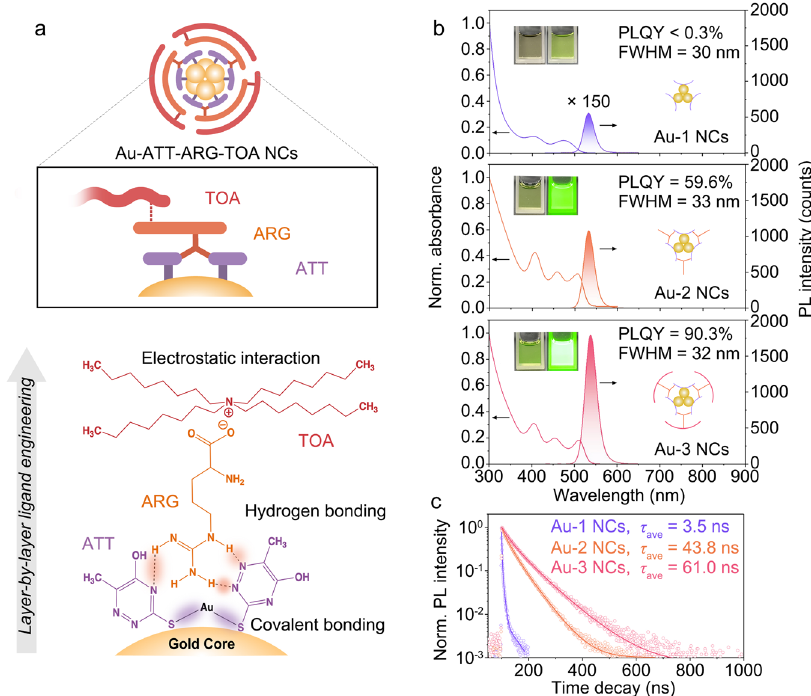
Fig. 1 | Structuralevolutionand opticalpropertiesofAu-1,Au-2, and Au-3NCs. a Schematic illustration of the triple-ligands layer-by-layer self-assembly evolution from the initial Au-1, intermediate Au-2, toterminalAu-3NCs. The schematicitems colored in purple,orange,and pinkdenotetogold NCscoated withATT, ARG,and TOA ligands, respectively. b UV-vis absorbance and luminescence spectra of Au-1,